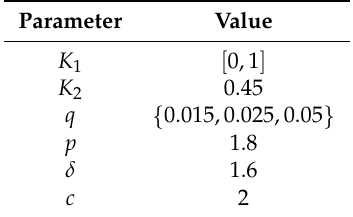
Table 3. Parameter values for the numerical